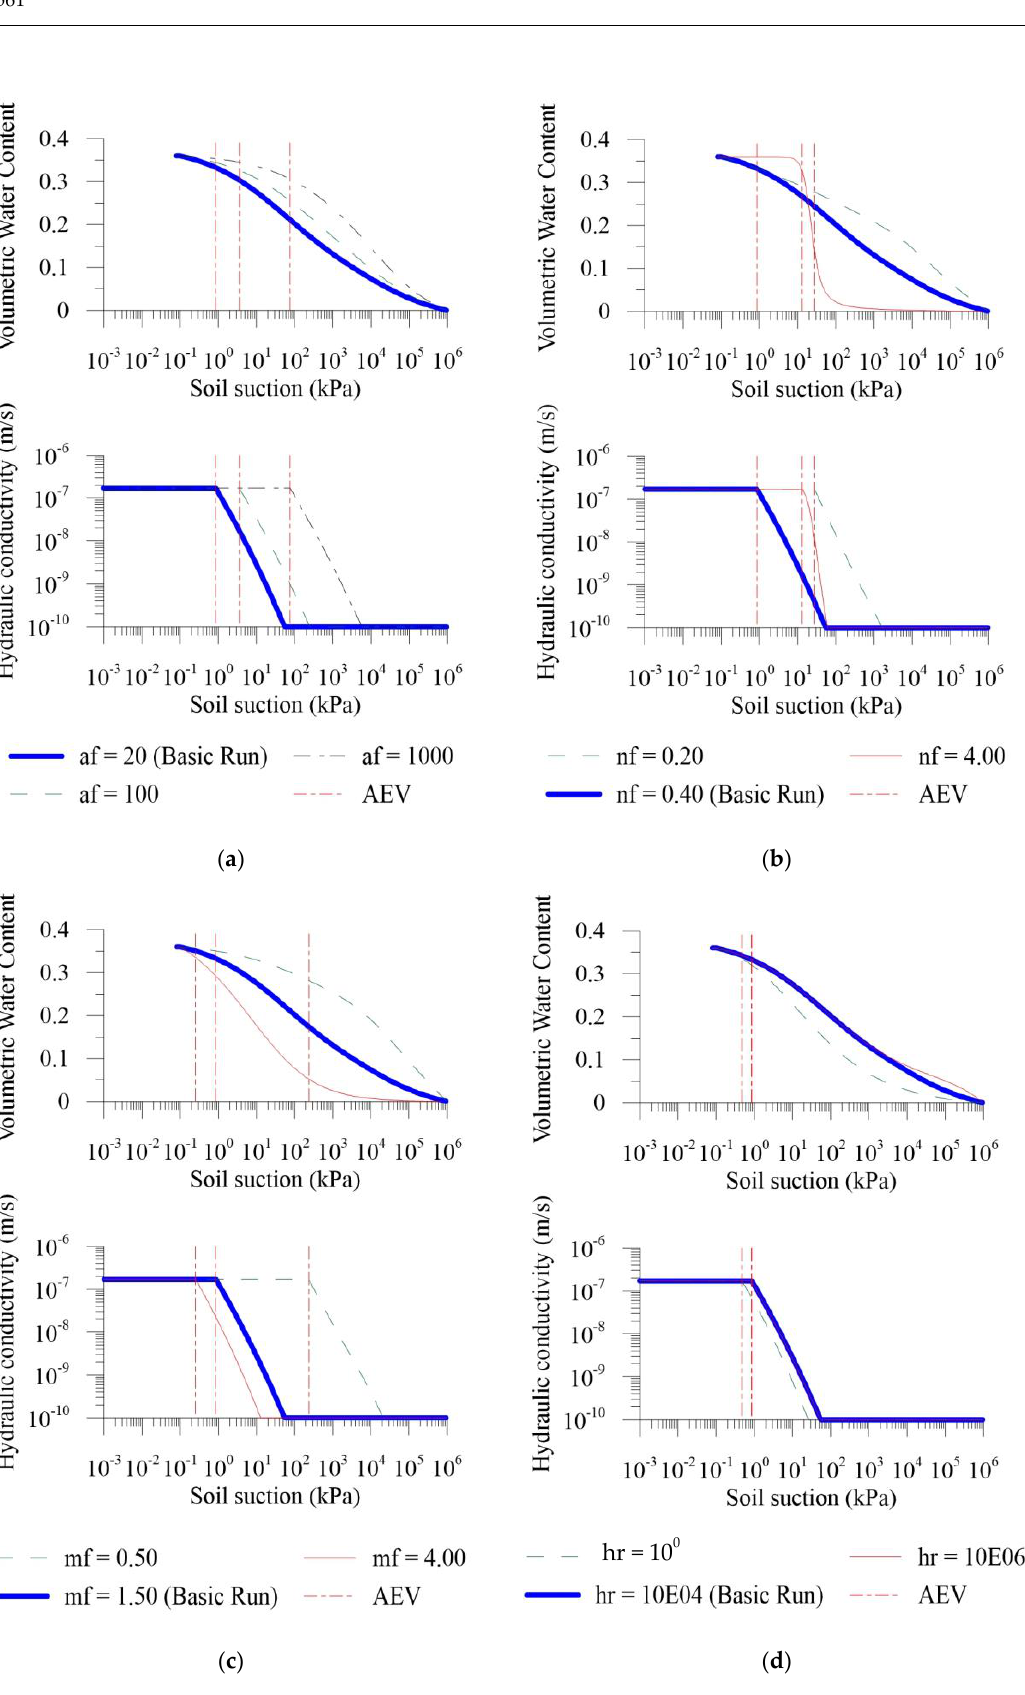
Figure 7. SWCC curves and permeability functions for different Fredlund and Xing parameter